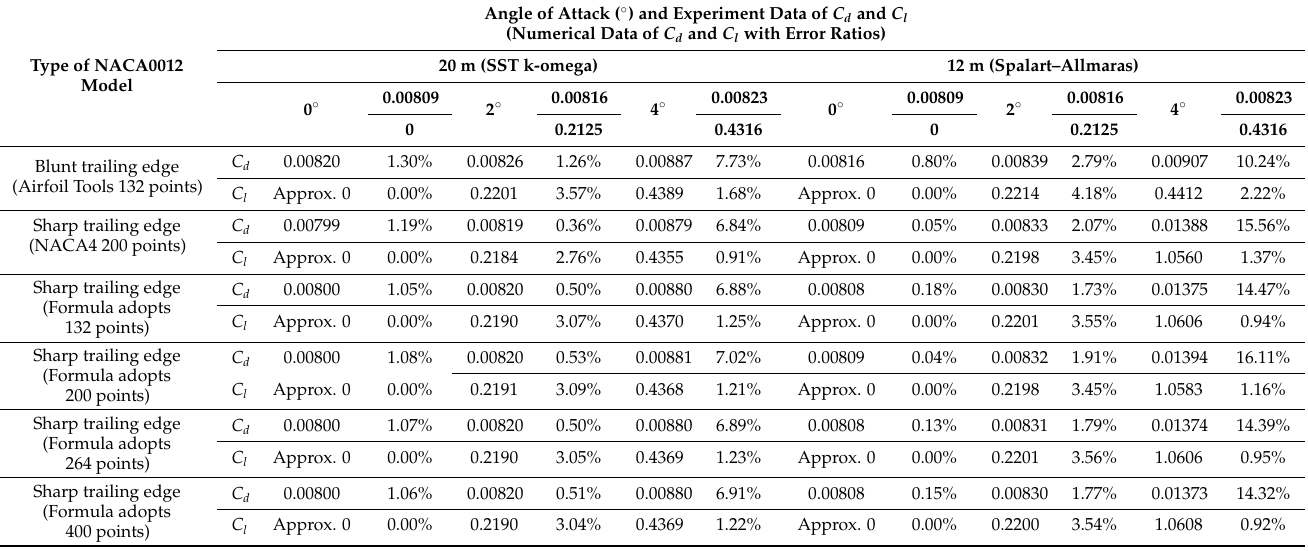
Table 6. Simulation results of C d and C l with error ratios adopting SST k-omega and a